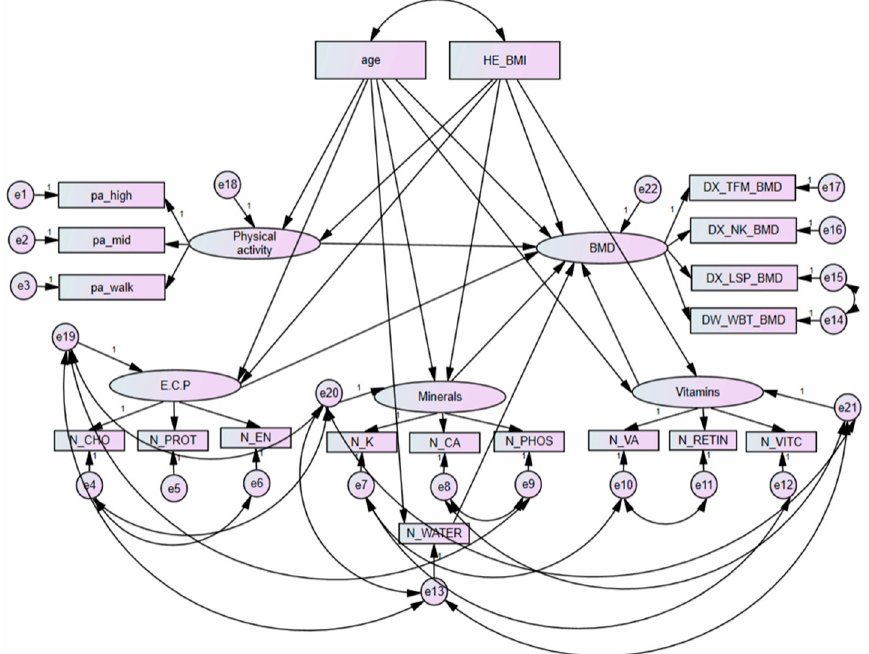
Figure 4. Results of direct pathways and total pathways with age, BMI, physical activity, and nutrient intakes in postmenopausal women with bone mineral density. Errors are presented with e1, e2, e3, e4, e5, e6, e7, e8, e9, e10, e11, e12, e13, e14, e15, e16, e17, e18, e19, e20, e21 and e22. BMD, bone mineral density; N_CA, calcium; N_CHO, carbohydrate; N_EN, energy; E.C.P., energy, carbohy-